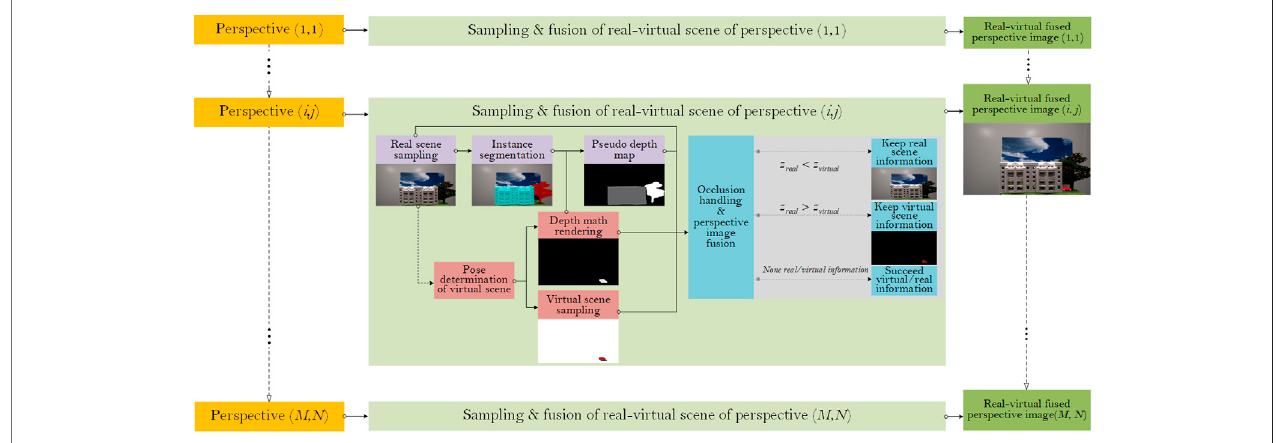
FIGURE 3 | Fusion strategy of real and virtual